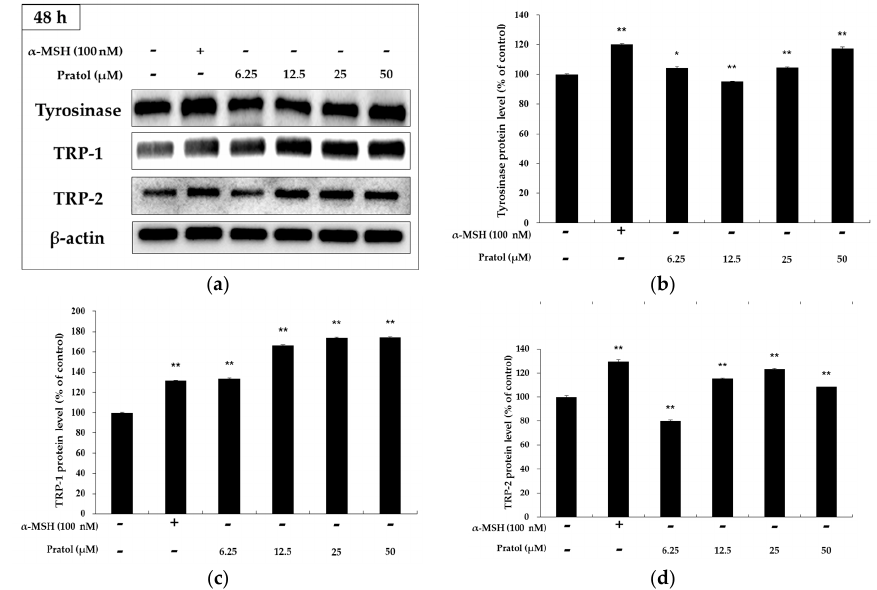
Figure 4. Effect of pratol on TRP-1, TRP-2, and tyrosinase expression in B16F10 cells. Cells were treated with various concentrations of pratol (6.25, 12.5, 25, or 50 μ M) for 48 h. Protein levels were examined by western blotting. ( a ) Result of western bolting, and protein level of ( b ) tyrosinase; ( c ) TRP-1 and ( d ) TRP-2. Results are expressed as a percentage of the control. The data are presented as mean ± SD of at least three independent experiments. * indicates p < 0.05, whereas ** indicates p < 0.01.